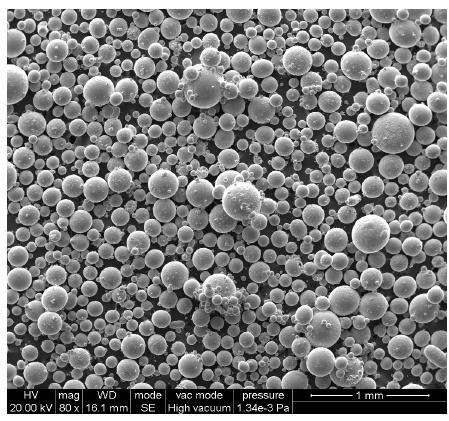
Figure 1. SEM image of the prealloyed powder manufactured by gas atomization. Table 1. Chemical composition of HIP (hot isostatic pressing) Ti-6Al-4V alloy (wt %).